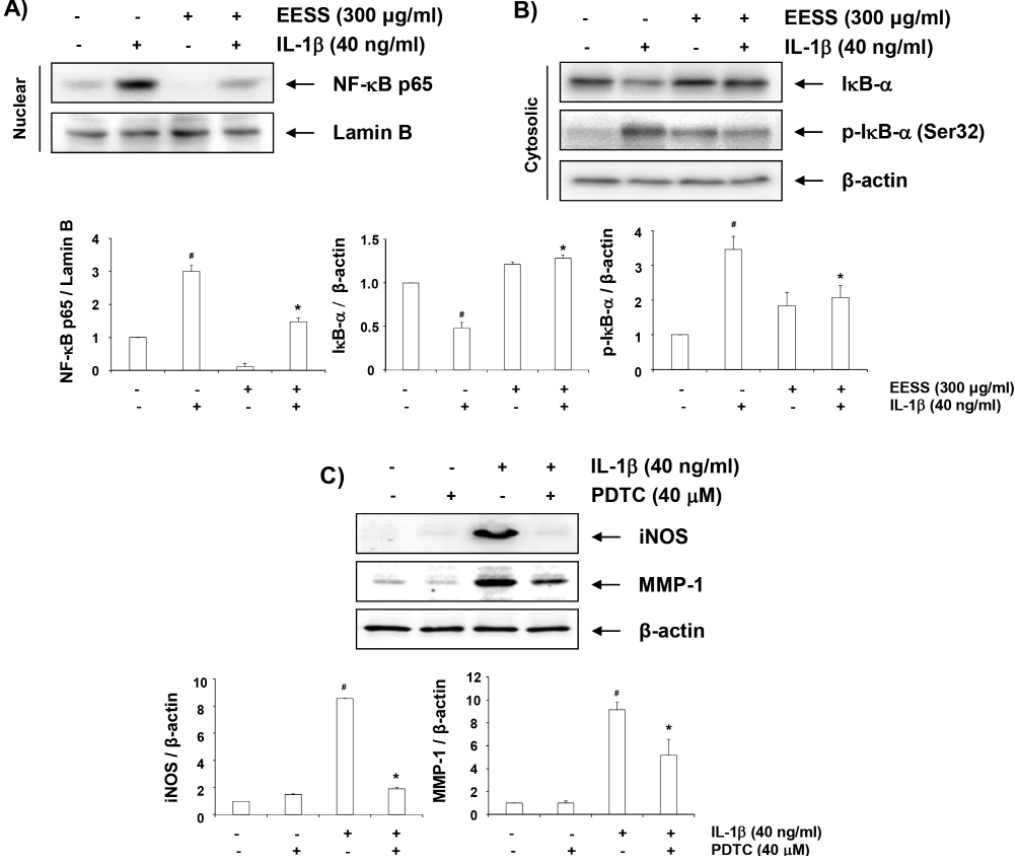
Figure 8. Effects of EESS on the IL-1 β -induced activation of NF- κ B. The cells were pretreated with 300 μ g/mL EESS for 1 h, before 40 ng/mL IL-1 β treatment ( A , B ) or 40 mM PDTC ( C ) for 1 h. The